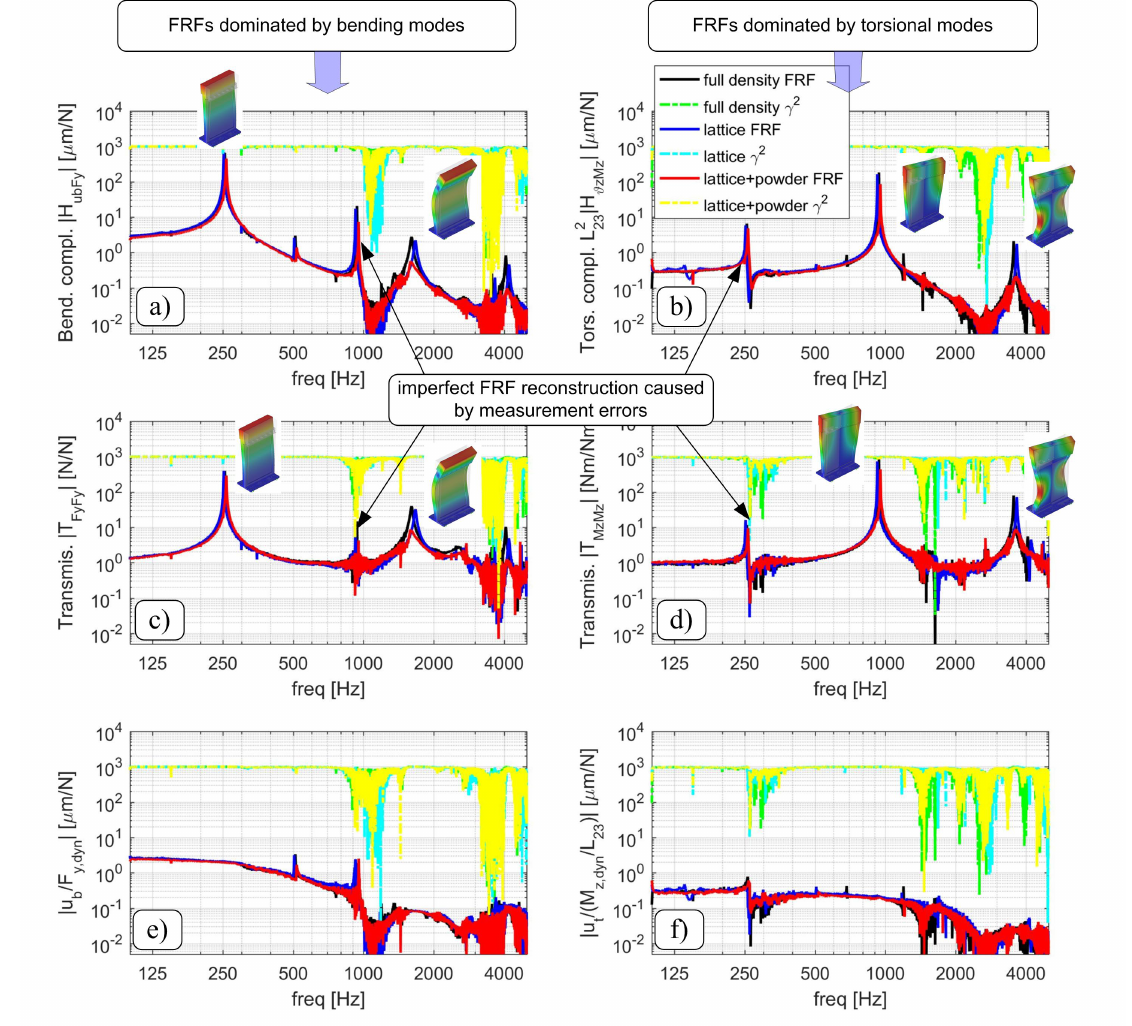
Figure 12. Dynamic behavior of blade top edge derived from modal analysis: bending compliance ( a ) and torsional compliance ( b ). Dynamometer’s transmissibilities along the F y ( c ) and M z ( d ) directions. Dynamic relation between the bending vibration u b and the measured feed perpendicular force F y , dyn ( e ). Dynamic relation between the torsional vibration u t (evaluated at blade corner—node 3) and the measured torque M z , dyn acting on the workpiece with respect to the blade vertical axis of symmetry ( f